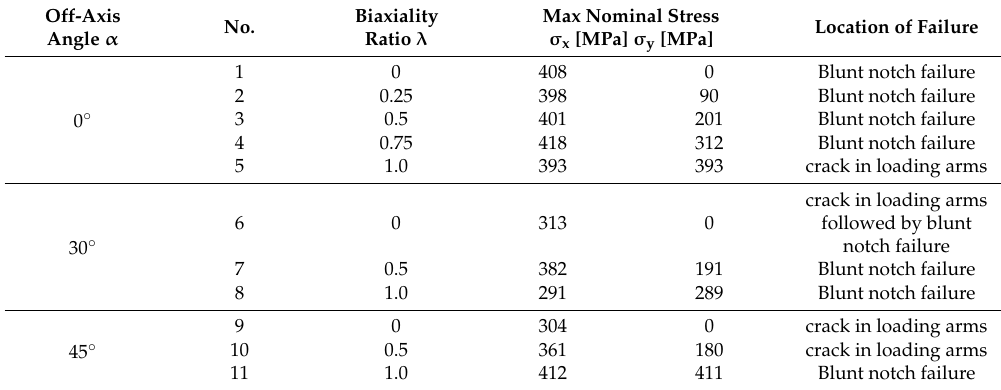
Table 2. Maximum nominal loads and location of failure obtained for all tested